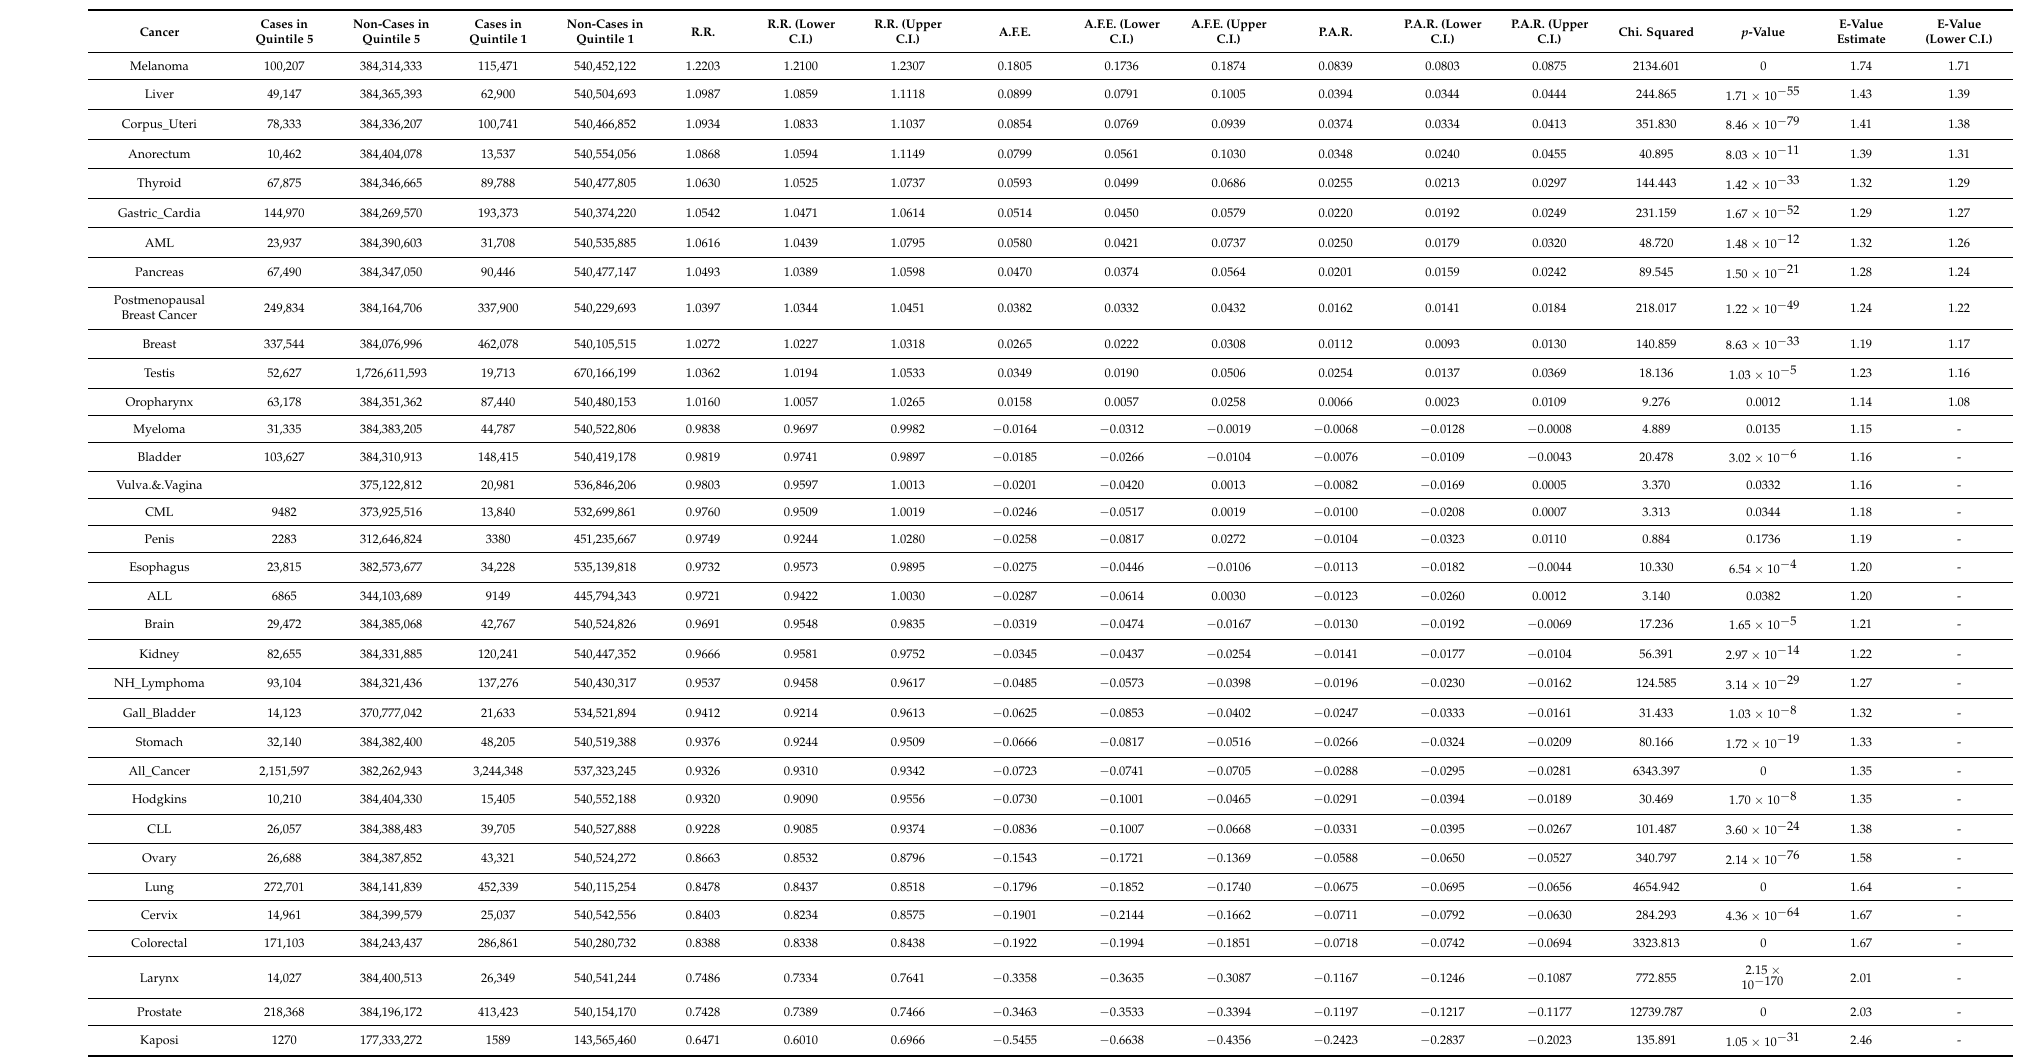
Table 1. The continuous bivariate relationships of ∆